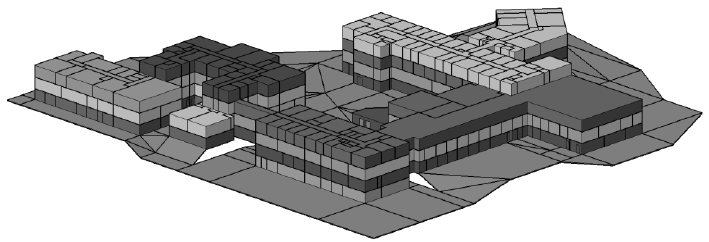
Figure 20. Full model represented as a set of unconnected cells.